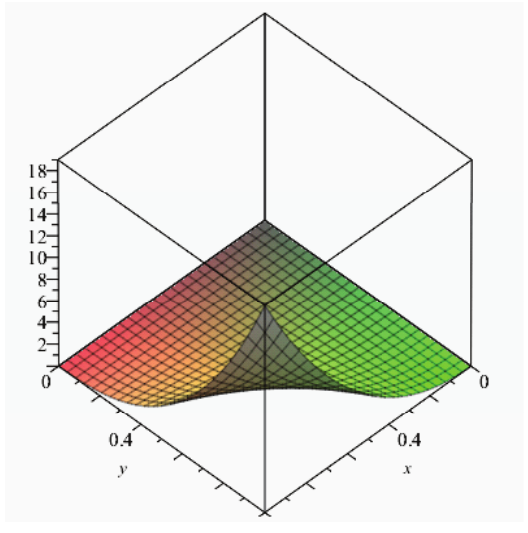
Figure 6: The plot for the M-polynomial of 1 R